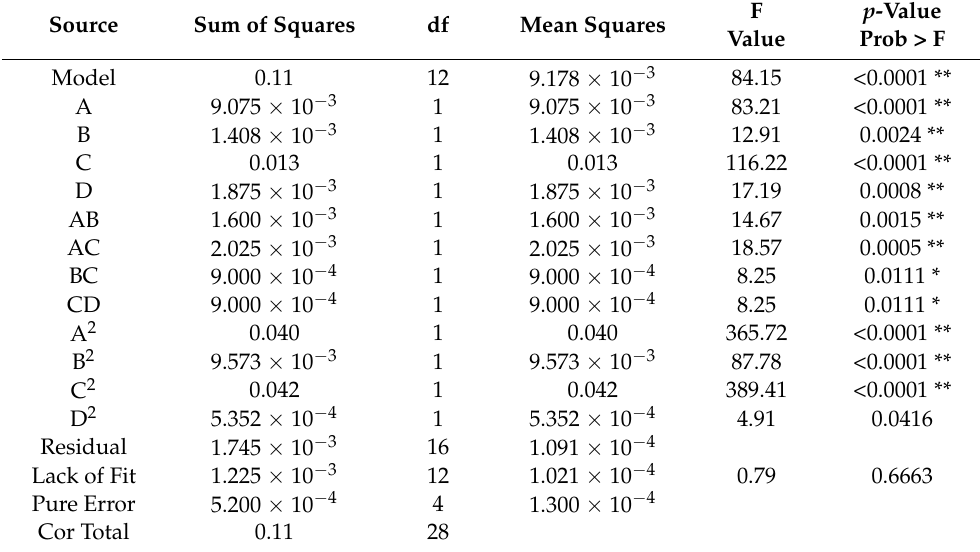
Table 5. Variance analysis of grain breakage